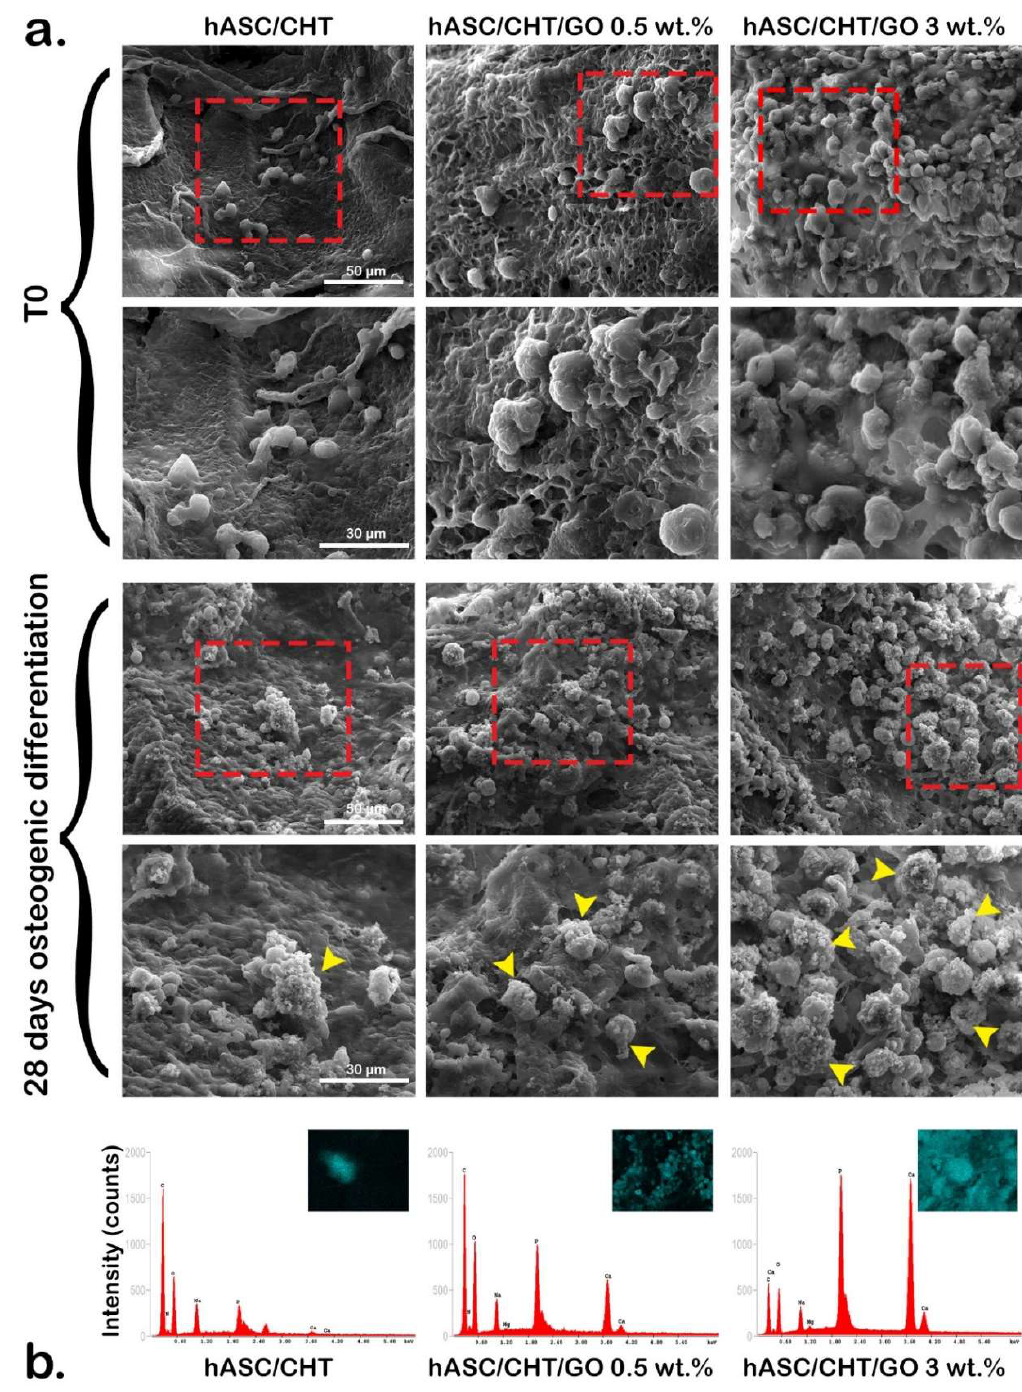
Figure 4. Cell distribution and phenotype in BC0.5–BC3 systems. ( a ) hASC distribution and morphology in the 3D structure of BC0.5–BC3 and the hASC / CHT reference bioconstruct (BC) before and after 28 days of osteogenic di ff erentiation, assessed by SEM; the red box marks the area enlarged below each image and the yellow arrows indicate mineralized deposits in the extracellular matrix (ECM) which was further characterized by EDAX; ( b ) the composition of extracellular matrix secreted by cells after 28 days of osteogenic di ff erentiation, as revealed by energy dispersive X-ray analysis (EDAX) analysis.